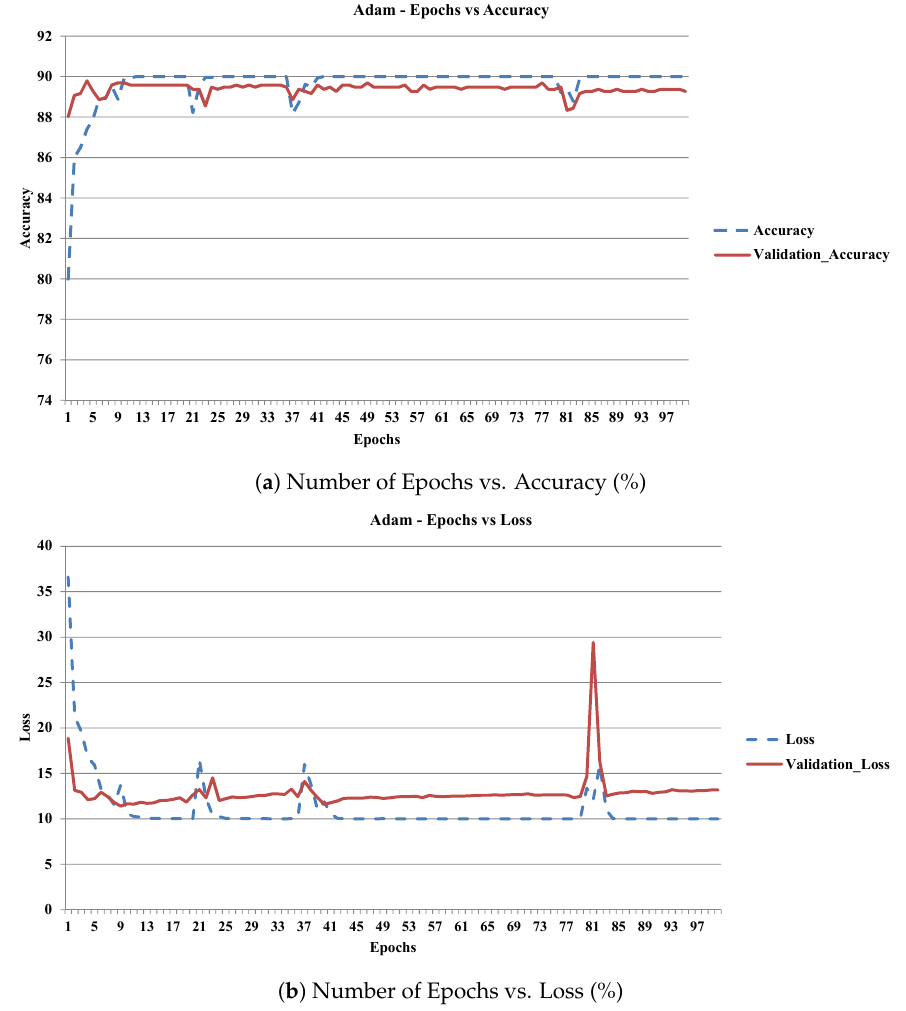
Figure 4. Accuracy and loss graph on training and validation data of Adam optimizer. Adamax: Adamax is one of the variants of Adam based on the infinity norm feature